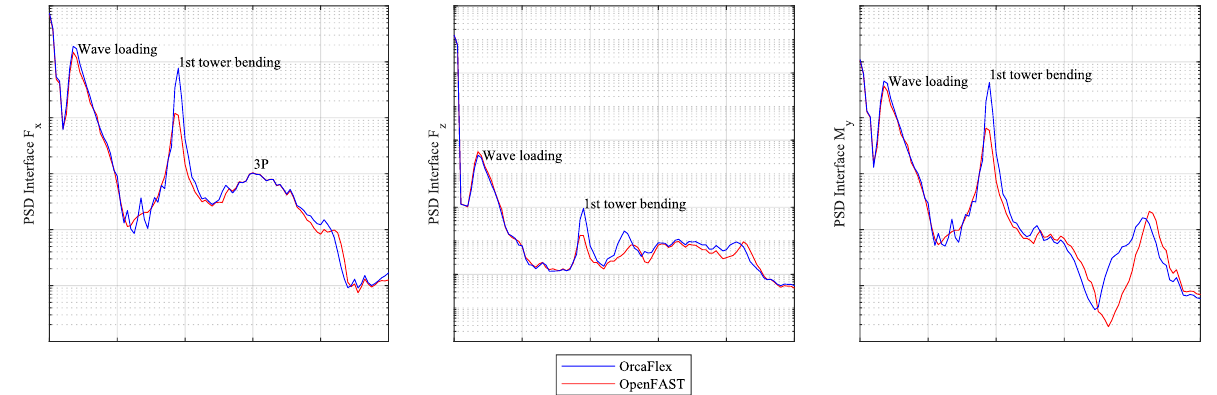
Figure 13. Power spectral density (PSD) of loads at the interface.